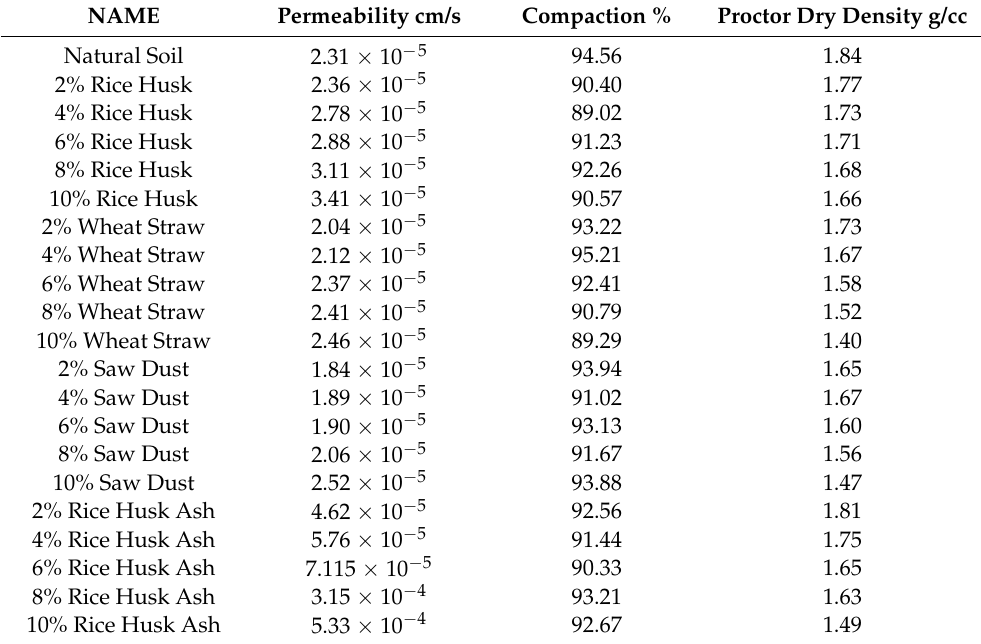
Table 2. Variation in permeability of treated